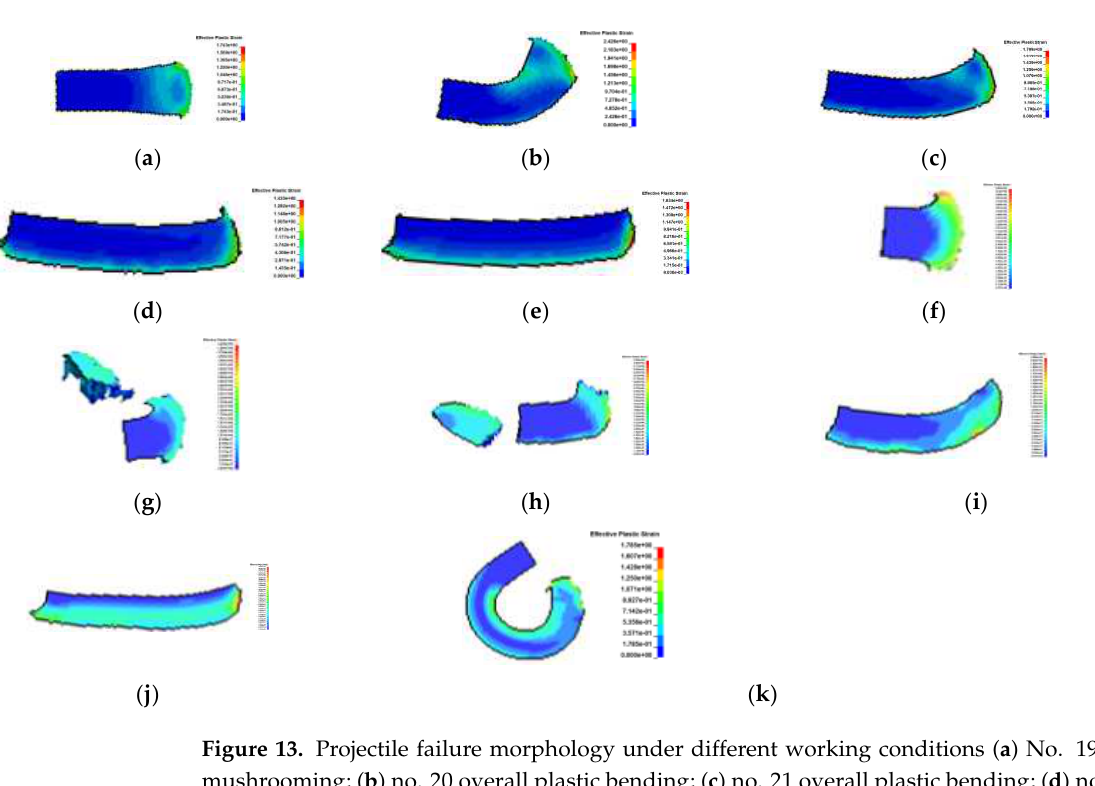
Figure 13. Projectile failure morphology under different working conditions ( a ) No. 19 erosion- mushrooming; ( b ) no. 20 overall plastic bending; ( c ) no. 21 overall plastic bending; ( d ) no. 22 side erosion; ( e ) no. 23 side erosion ( f ) no. 29 erosion—mushrooming; ( g ) no. 30 fracture; ( g ) no. 31 fracture; ( i ) no. 32 overall plastic bending; ( j ) no. 33 side erosion; ( k ) no. 34 bending.